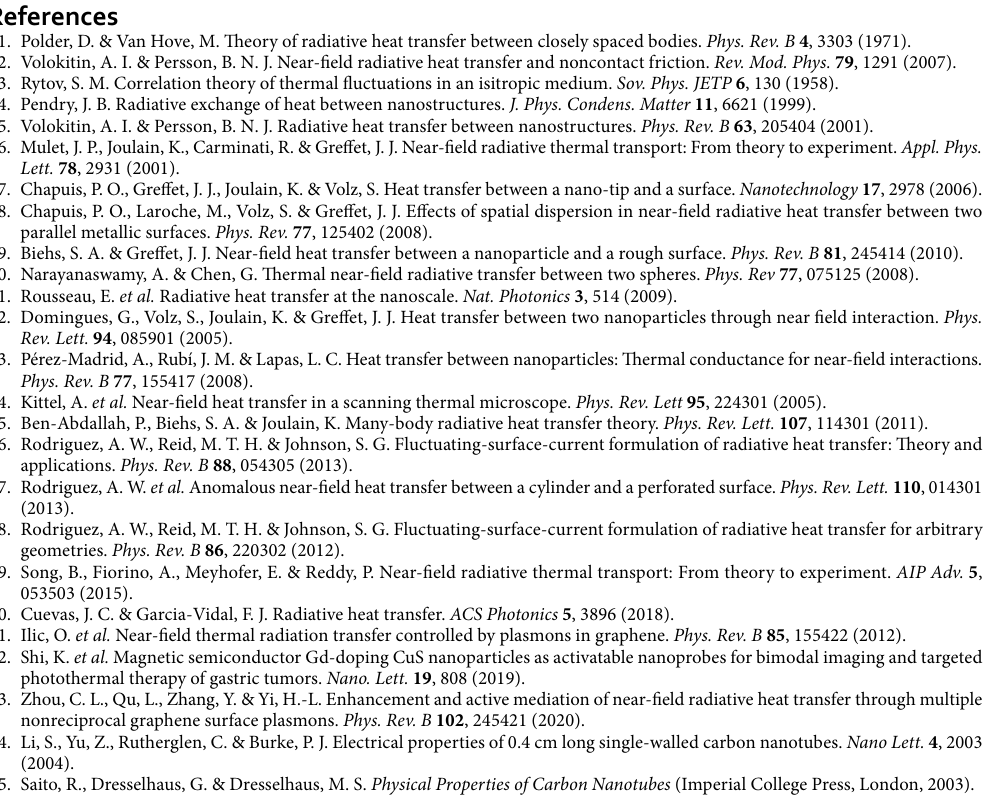
Figure 8. Normalized radiative heat transfer per unit length versus distance between CNTs (in nanometers), plotted in a logarithmic scale, computed for m 14 10 τ s (dashed − =